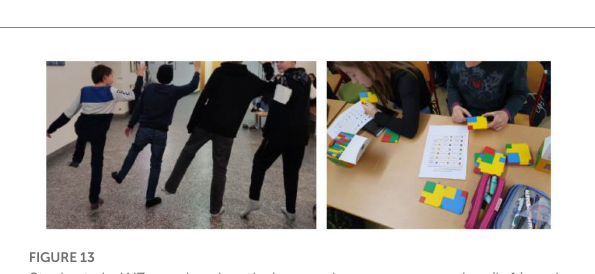
FIGURE 13 Students in W3 are dancing their own dance programming (left) and creating new codes for every movement using the PolyUni tiles